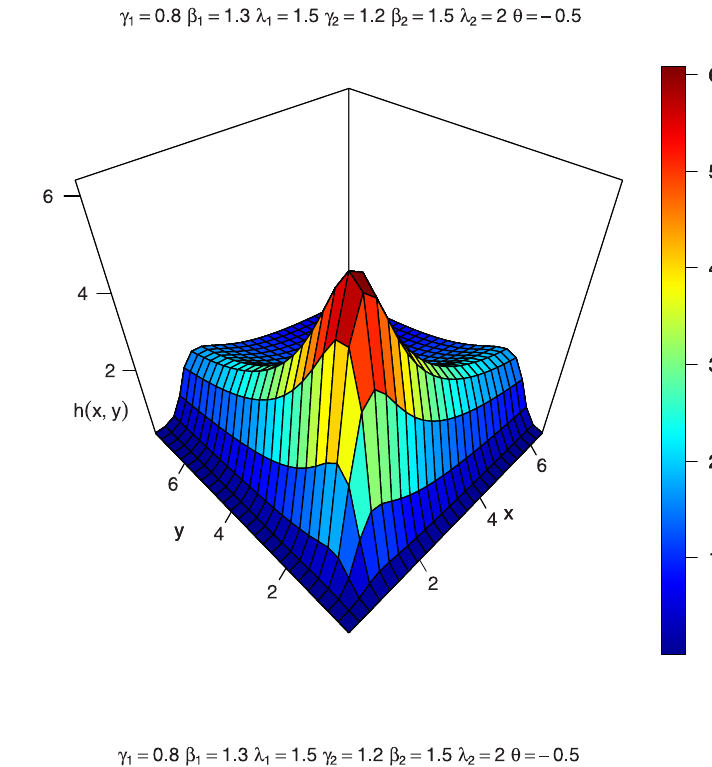
Fig 4. 3-dimension of joint hazard of